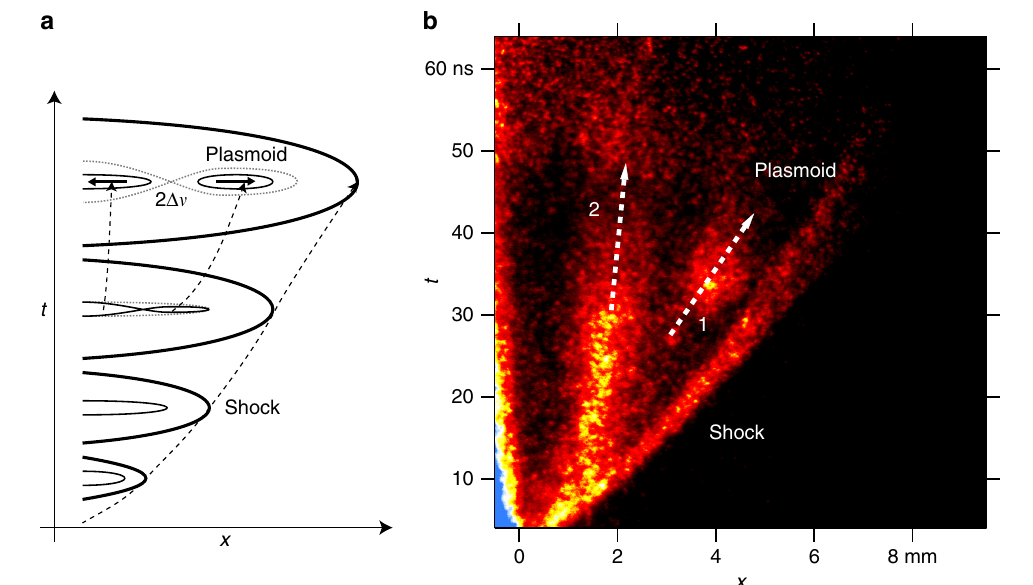
Fig. 4 Time evolution of shock, plasma, and plasmoid. a Schematic Image of the time evolution of the magnetic reconnection. b Streaked self-emission optical pyrometer (SOP) image. The white arrows 1 and 2 indicate the velocities of the plasma